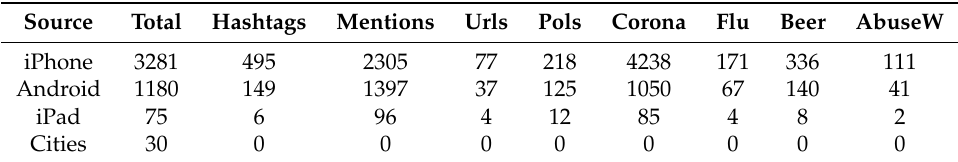
Table 1. Tweet features summarized by source